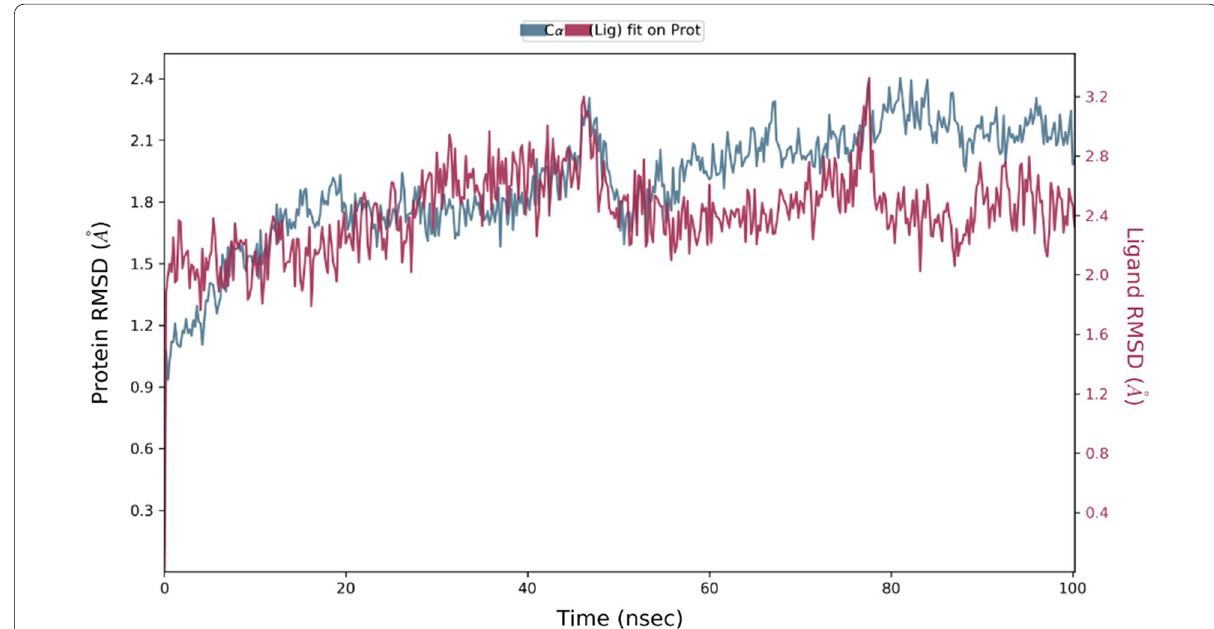
Fig. 3 RMSD plot obtained for derivative C-02- Pf -DHODH protein (PDB ID: 4CQ8, resolution 1.98 Å ) complex